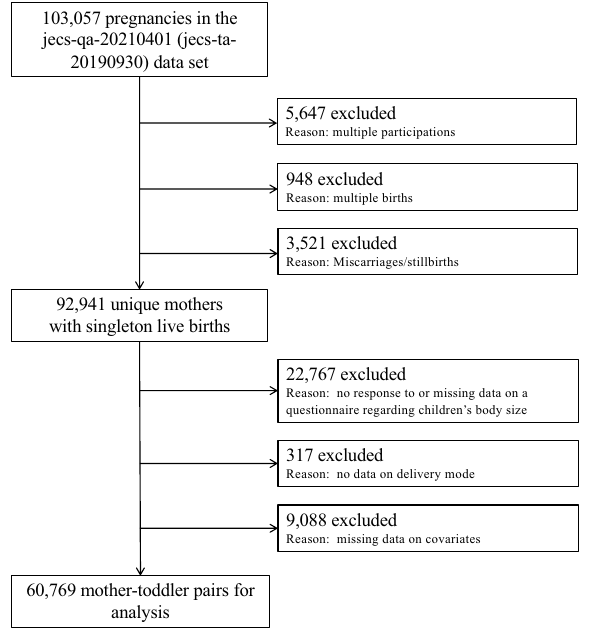
Figure 1. Flow diagram showing the recruitment process for pregnant women and reasons for exclusion in this